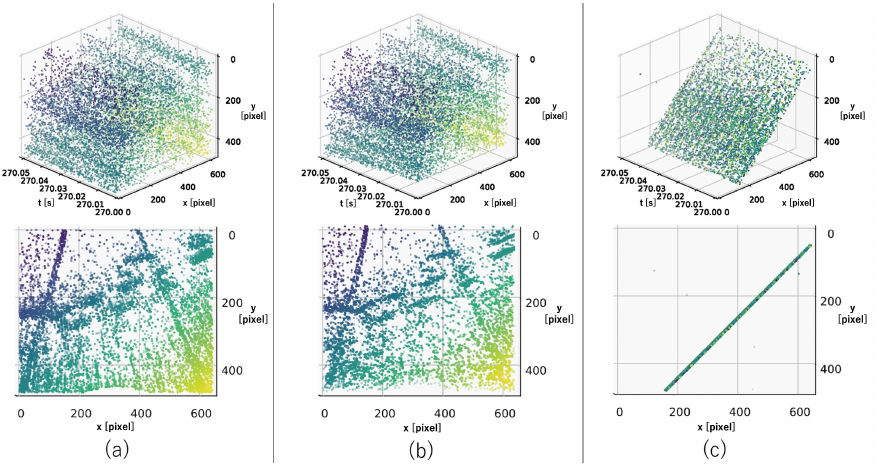
Figure 6. ( a ) Events before warp. ( b ) Events warped by the true value. ( c ) Events warped by a failed homographic motion estimation. The top row shows how the events were warped by homographic motion estimation in the XYT space. The bottom row shows how they are projected to the